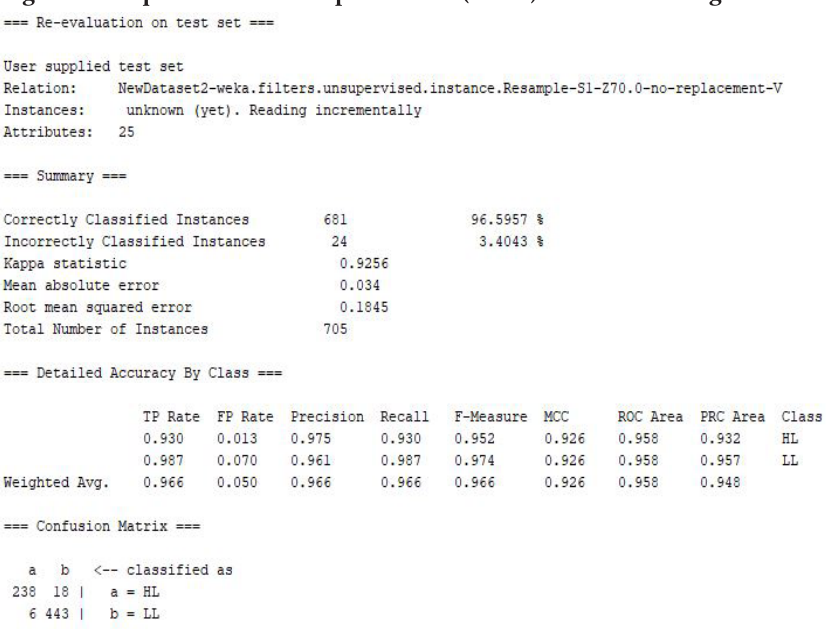
Figure 11: Sequential minimal optimisation (SMO) model for testing dataset